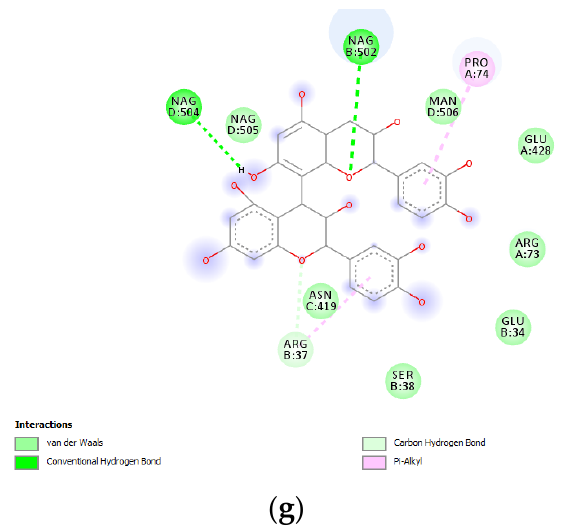
Figure 7. ( a ) Putative interactions between apigenin and tyrosinase (Protein Data Bank (PDB): 5M8P). Free energy of binding (ΔG) and affinity (Ki) are − 6.8 kcal/mol and 10.5 μM, respectively. ( b ) Putative interactions between quercetin and tyrosinase (PDB: 5M8P). Free energy of binding (ΔG) and affinity (Ki) are -7.1 kcal/mol and 6.3 μM, respectively. ( c ) Putative interactions between isovitexin and tyrosinase (PDB: 5M8P). Free energy of binding (ΔG) and affinity (Ki) are − 8.9 kcal/mol and 0.3 μM, respectively. ( d ) Putative interactions between vitexin and tyrosinase (PDB: 5M8P). Free energy of binding (ΔG) and affinity (Ki) are − 9.0 kcal/mol and 0.3 μM, respectively. ( e ) Putative interactions between luteolin and tyrosinase (PDB: 5M8P). Free energy of binding (ΔG) and affinity (Ki) are − 8.3 kcal/mol and 0.8 μM, respectively. ( f ) Putative interactions between methoxy-trihydroxy(iso)flavone and tyrosinase (PDB: 5M8P). Free energy of binding (ΔG) and affinity (Ki) are − 6.5 kcal/mol and 17.4 μM, respectively. ( g ) Putative interactions between procyanidin B and tyrosinase (PDB: 5M8P). Free energy of binding (ΔG) and affinity (Ki) are − 8.6 kcal/mol and 0.5 μM, respectively.